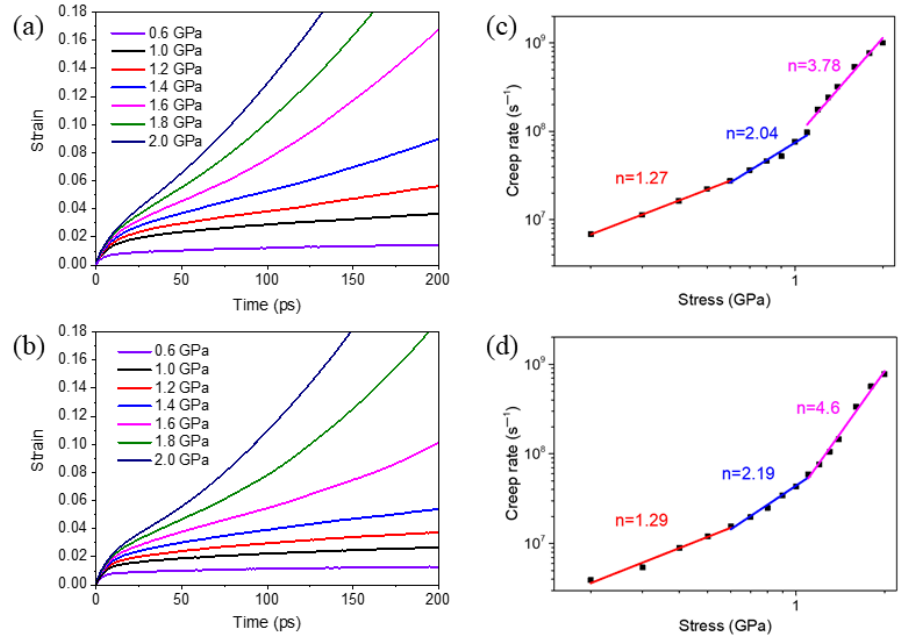
Figure 2. ( a , b ) Creep curves of the NC Ni and the segregated Ni-Mo (3 at.%) samples with 𝑑 = 10.9 nm at 1100 K under various applied stresses, respectively; ( c , d ) Dual logarithmic plots of the creep strain rate versus stress of NC Ni sample and segregated Ni-Mo (3 at.%) samples with 𝑑 = 10.9 nm rate versus stress of NC Ni sample and segregated Ni-Mo (3 at.%) samples with d = 10.9 nm at at 1100 K, respectively. 1100 K,